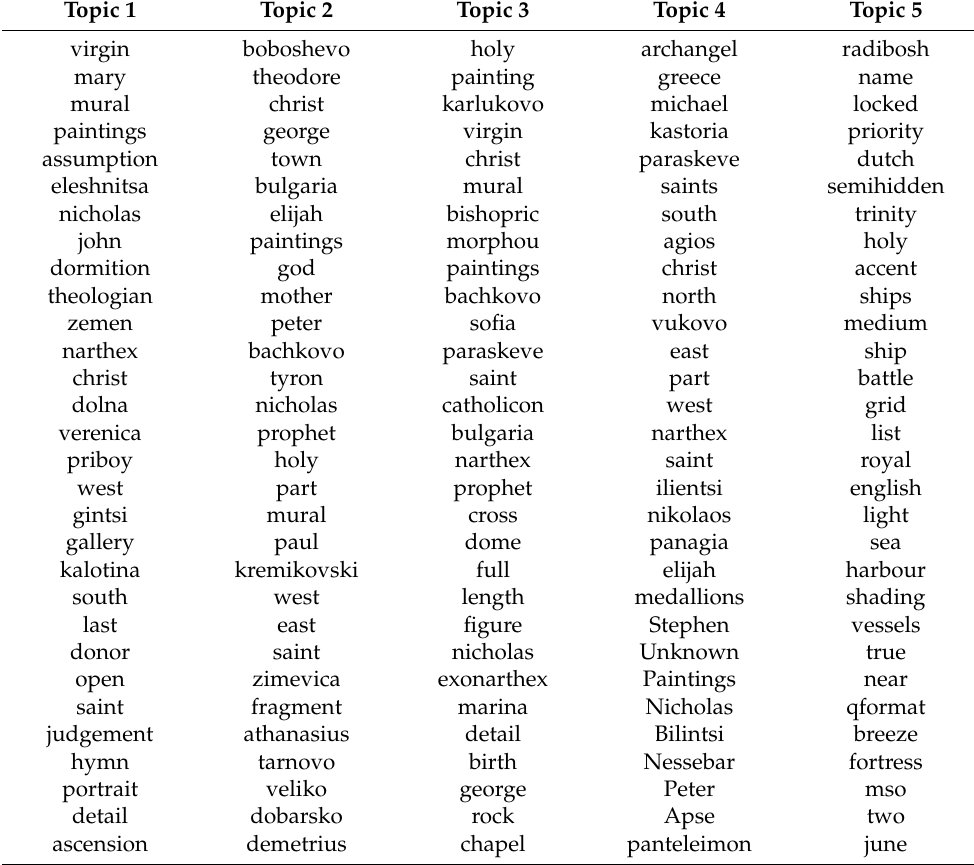
Table 1. Terms of each topic by order of relevance.